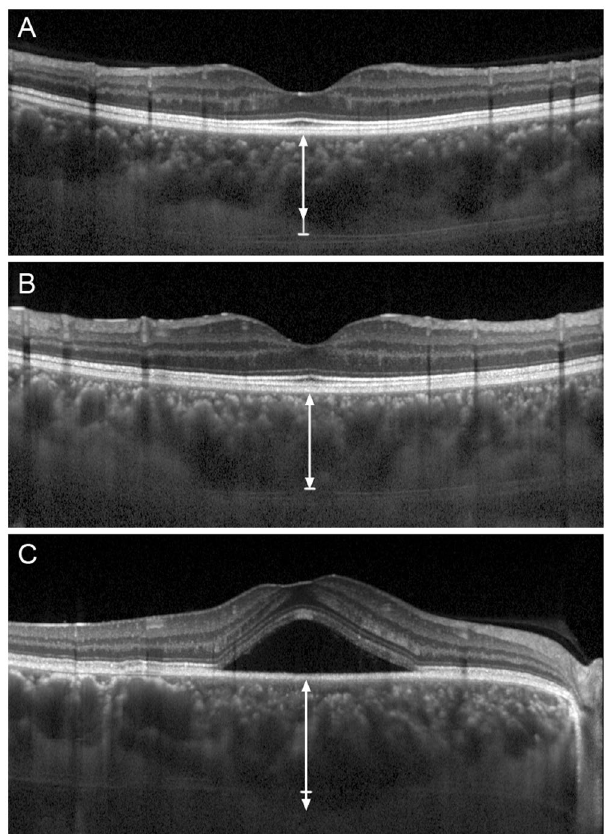
Figure 1. Example of a linear artifact line (small linear segment) below, at the same level as or above the sclerochoroidal interface (bidirectional arrow) in EDI-OCT images. ( A ) A female chronic primary angle closure glaucoma patient with a linear artifact line below the sclerochoroidal interface with a SFCT of 429 μ m. ( B ) A control male subject in which the linear artifact was at the same level as the sclerochoroidal interface with a SFCT value of 485 μ m. ( C ) A central serous chorioretinopathy patient with a linear artifact line above the sclerochoroidal interface with a SFCT of 573 μ m. SFCT: subfoveal choroidal